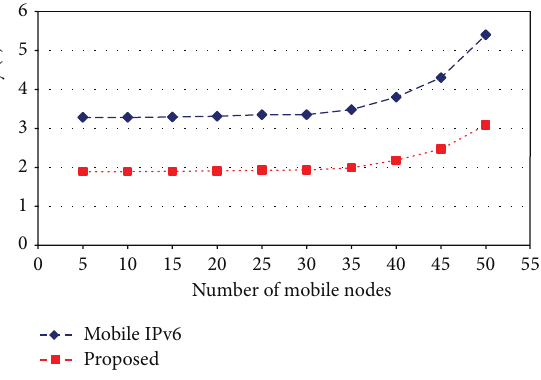
Figure 11: Packet loss comparison as a function of number of